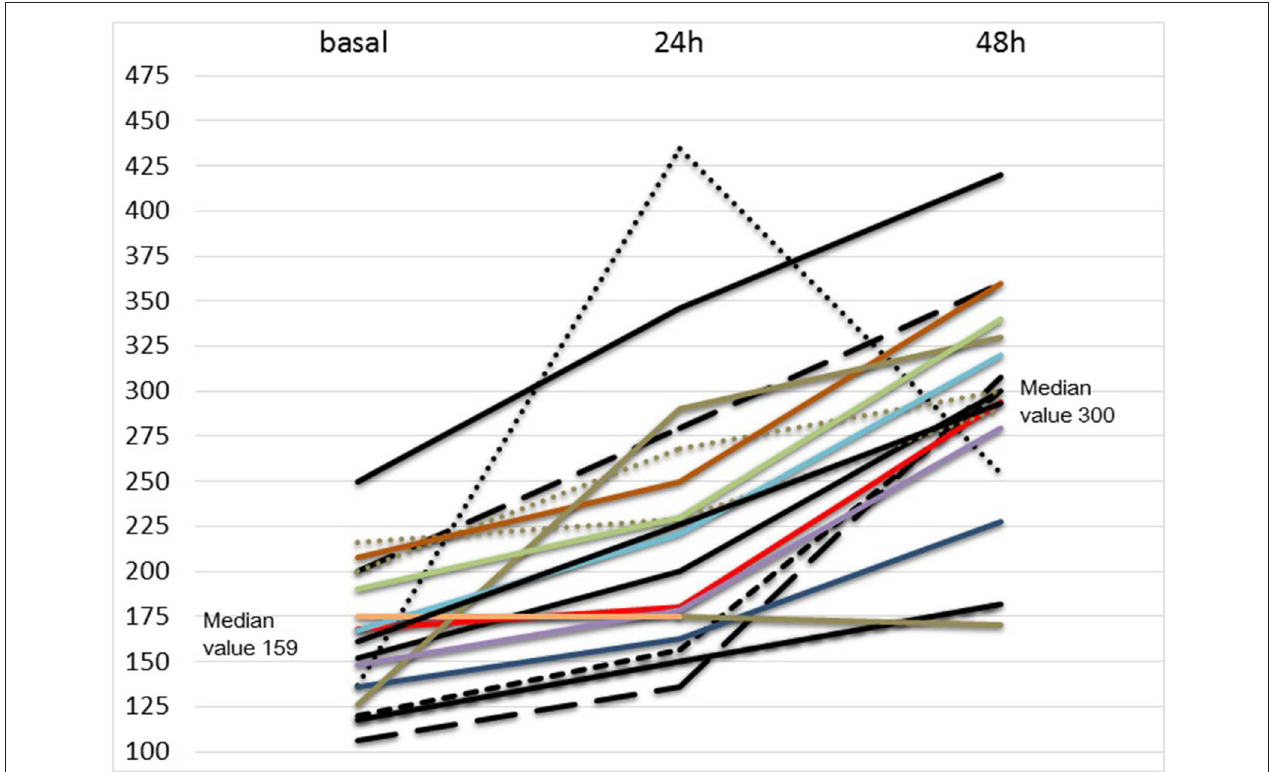
FIGURE 1 | pO 2 /FiO 2 ratio in first 48h of ruxolitinib treatment.